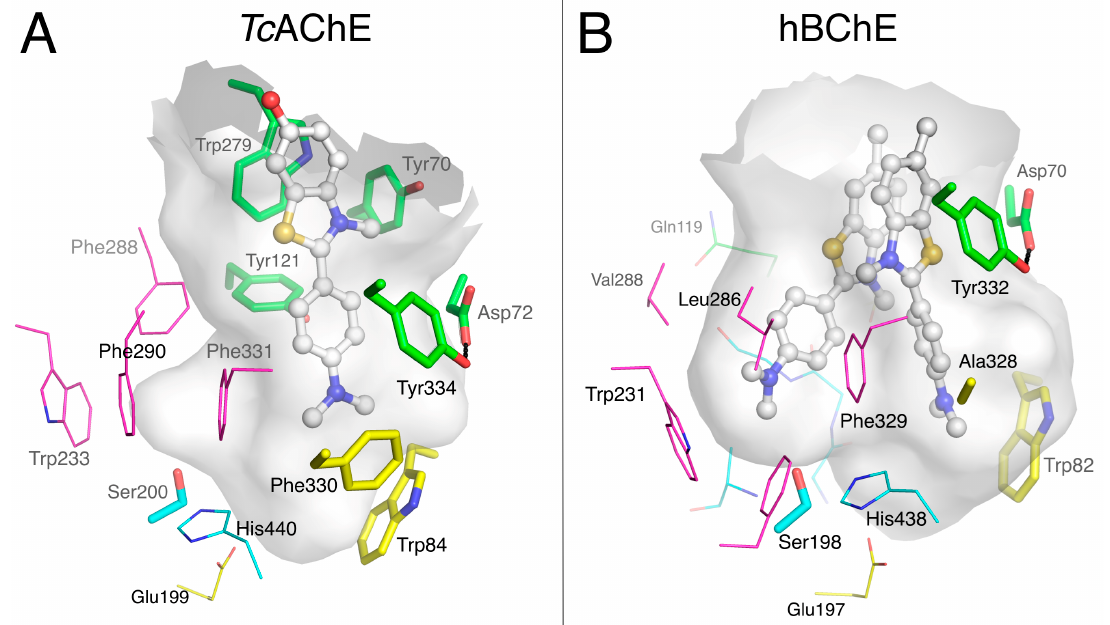
Figure 4. Complexes of thioflavin T with Tc AChE ( A ; pdb 2j3q) and hBChE ( B ; pdb 6esy). The gorge is depicted by its molecular surface (semi-transparent gray). Nitrogen atoms are in blue, oxygen atoms in red, sulfur atoms in yellow. The ligand is represented in ball and stick with carbon atoms in white. The residues in the vicinity of the ligand are represented in stick or lines. In the A-site, catalytic and oxyanion hole residues are in cyan, choline-binding pocket residues in yellow and acyl-binding pocket residues in magenta. P-site residues are in green.